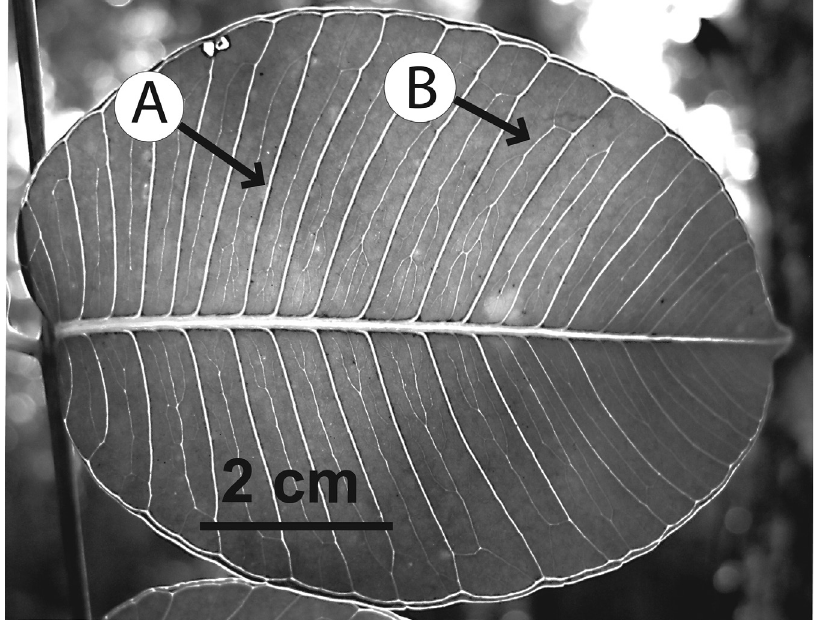
Figure 6. Leaf architecture of Spondias venulosa . A Straight secondary vein course B Admedial tertiary vein (from Stefano et al. 201 ,